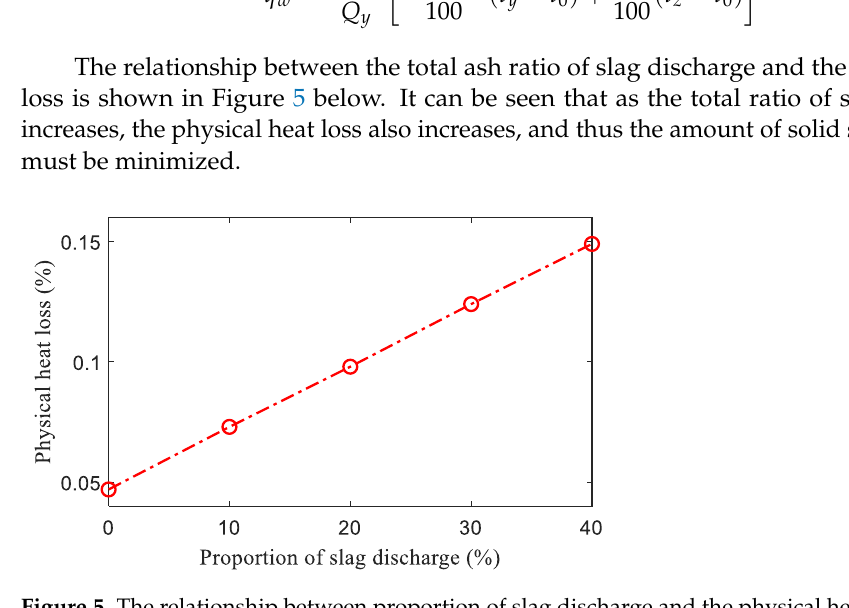
Figure 5. The relationship between proportion of slag discharge and the physical heat loss.